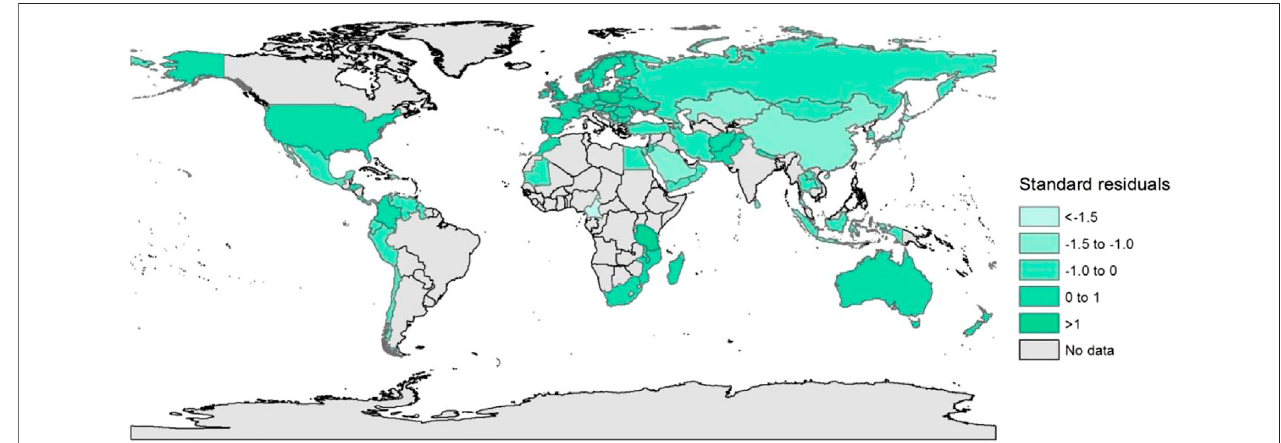
FIGURE 2 | Standard residuals for Model 1 (pop, GDP per capita, Internet users and education).